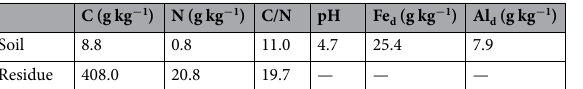
Table 1. Basic properties of soil and plant residues used in the incubation